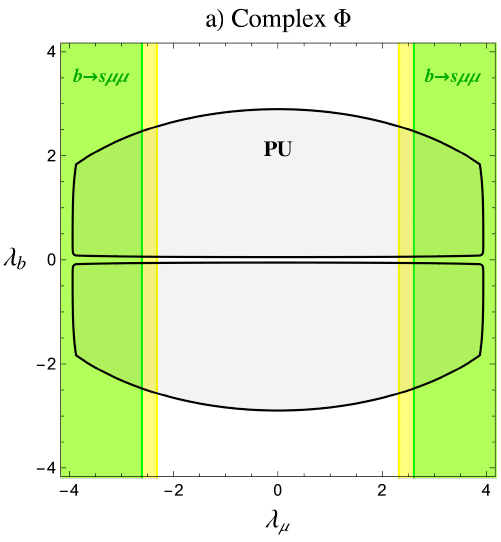
Figure 4 . In gray we show the regions of the parameter space compatible with PU. In green and yellow we show the regions compatible with the R